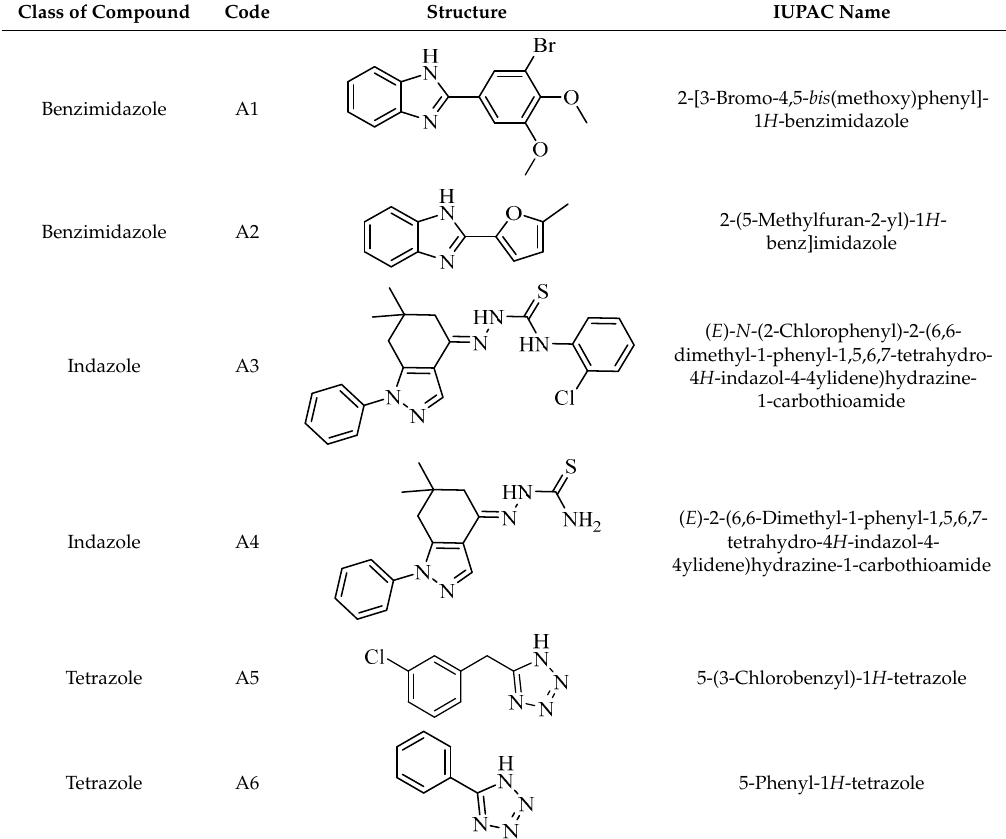
Table 1. The table shows the structures and IUPAC names of the azoles